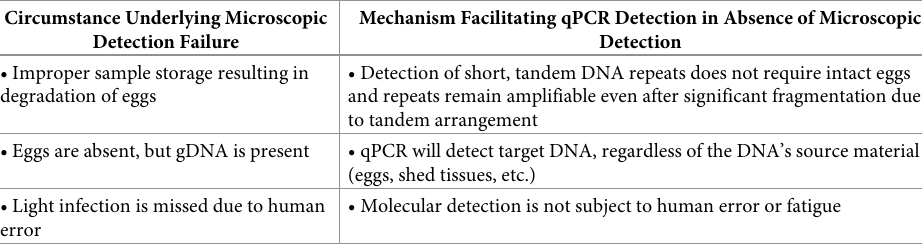
Table 4. Causes of PCR positivity in the absence of microscopic identification of